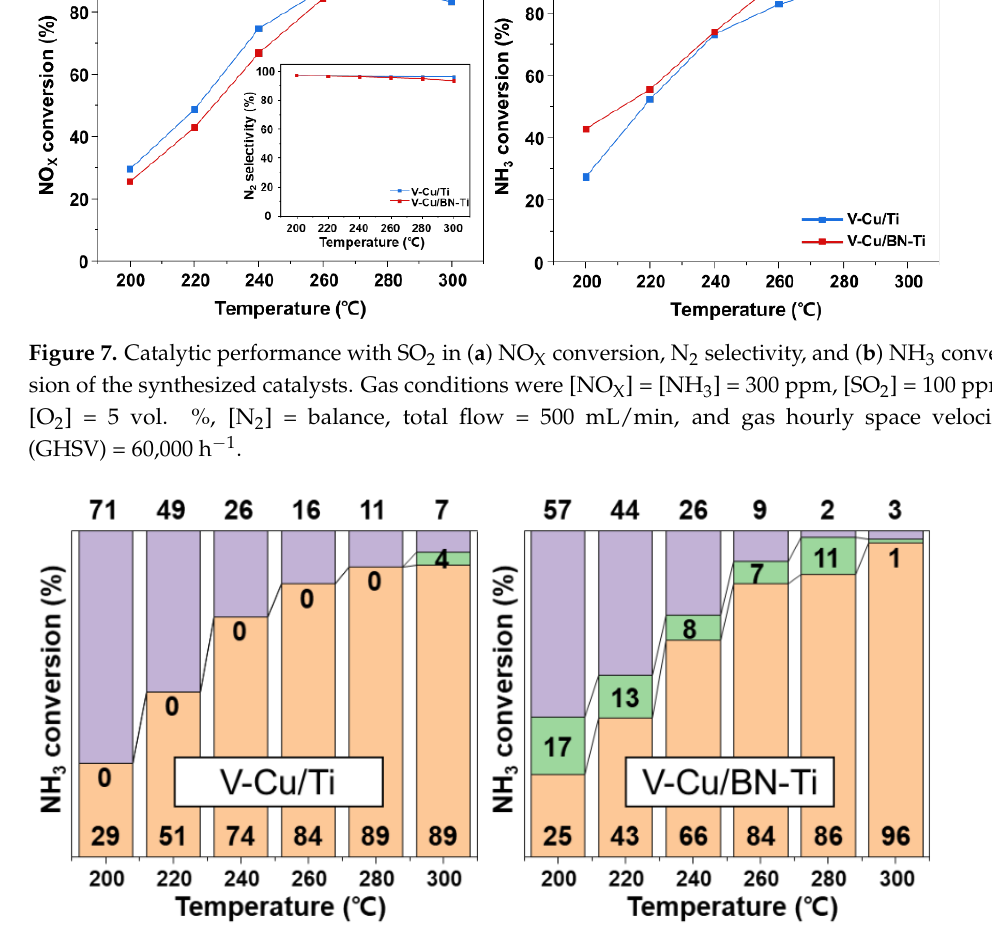
Figure 8. Slipped NH 3 oxidation performance during NH 3 conversion with SO 2 of the synthesized catalysts, NH 3 -SCR (orange bar), NH 3 -SCO (green bar) and NH 3 -Slip (purple bar) calculated using Equation (11). Gas conditions were [NO X ] = [NH 3 ] = 300 ppm, [SO 2 ] = 100 ppm, [O 2 ] = 5 vol. %, [N 2 ] = balance, total flow = 500 mL/min, and GHSV = 60,000 h − 1 .